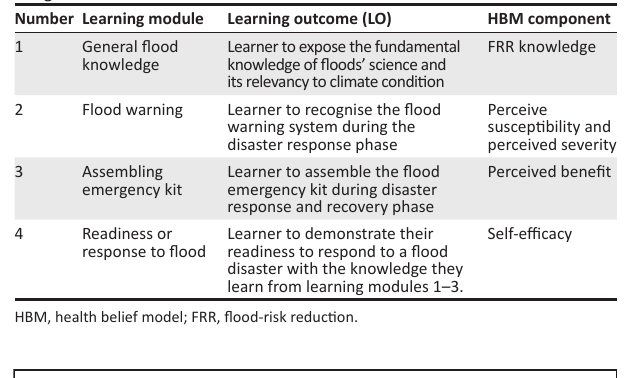
Pre-test interven(cid:22)on